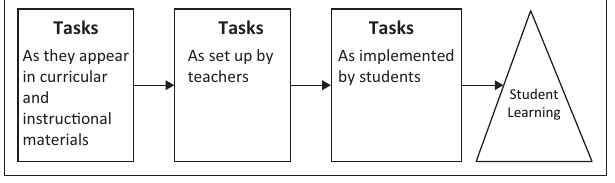
FIGURE 1: The mathematics tasks